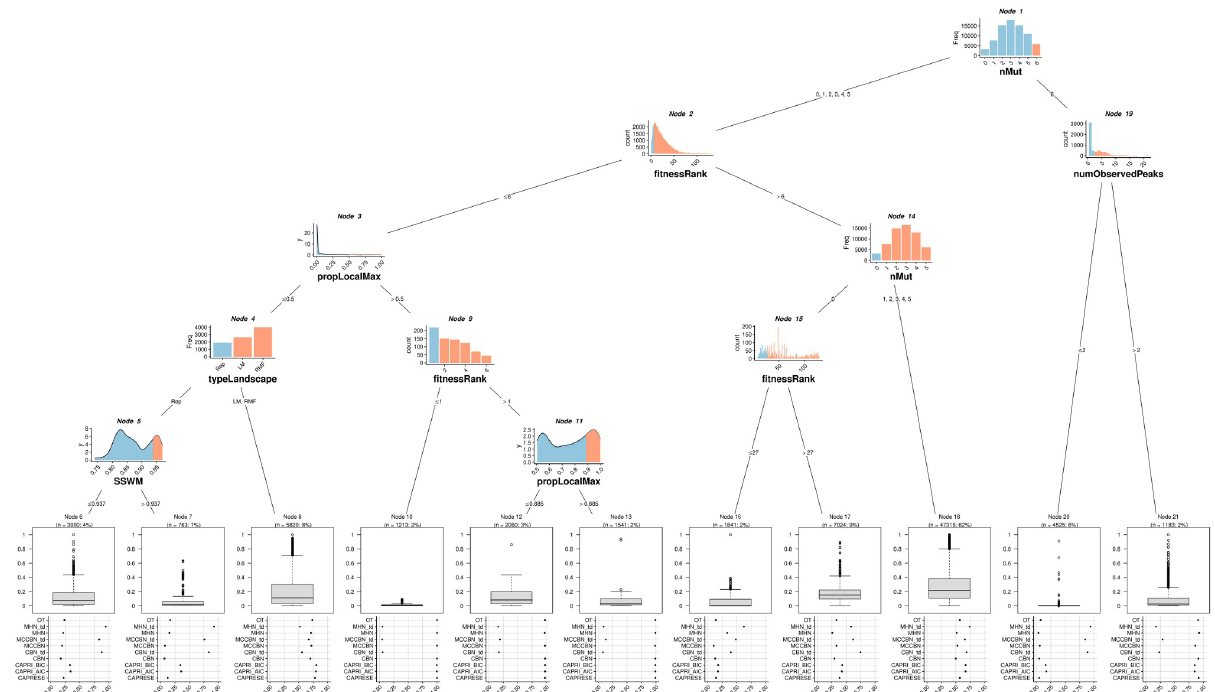
Fig 2. Linear mixed-effects model tree fitted to data from fitness landscapes with 7 loci, sample size of 4000 and uniform sampling. In the fitted models, the dependent variable is the minimal JS over all methods considered (i.e., the best possible performance): values closer to 0 represent better performance. Internal nodes show the partitioning variables and the values that lead to each partition; light blue denotes the values or categories that lead down the left split and salmon the values or categories that lead down the right split (partitioning criteria are also shown in the edges leading down a node). Leaves or terminal nodes show (weighted) boxplots of the dependent variable, the minimal JS over all methods considered, for the observations that fall in that leaf and, as label, the name of the node and the sample size (sum of weighted observations and % of the total data set for the fit). The dot plots underneath the boxplots show the (weighted) mean JS for each method for that